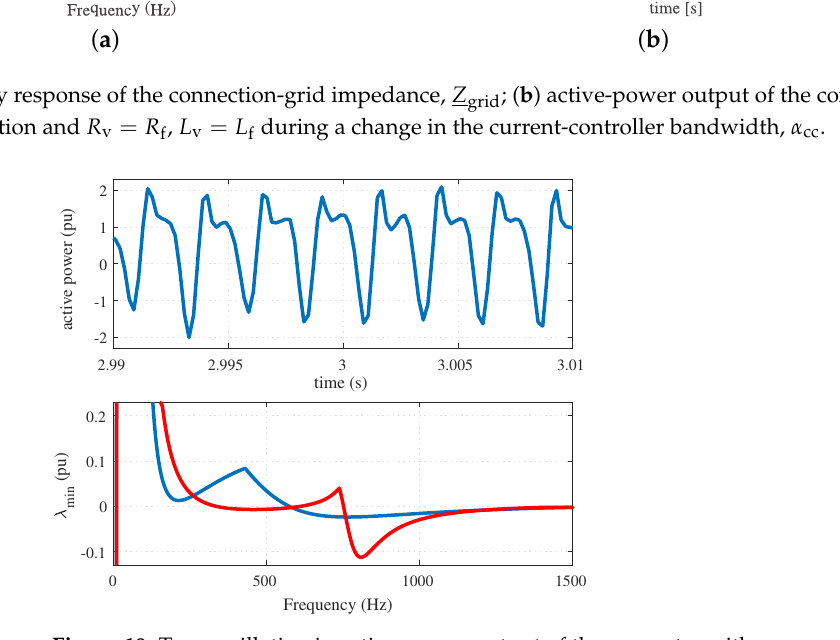
Figure 10. Top: oscillation in active-power output of the converter with a resonance grid connection during a change in the current-controller bandwidth; bottom: frequency response of the passiv- ity index λ min ; the bandwidth of the current controller is chosen at 6 pu (blue curve) and 15 pu (red